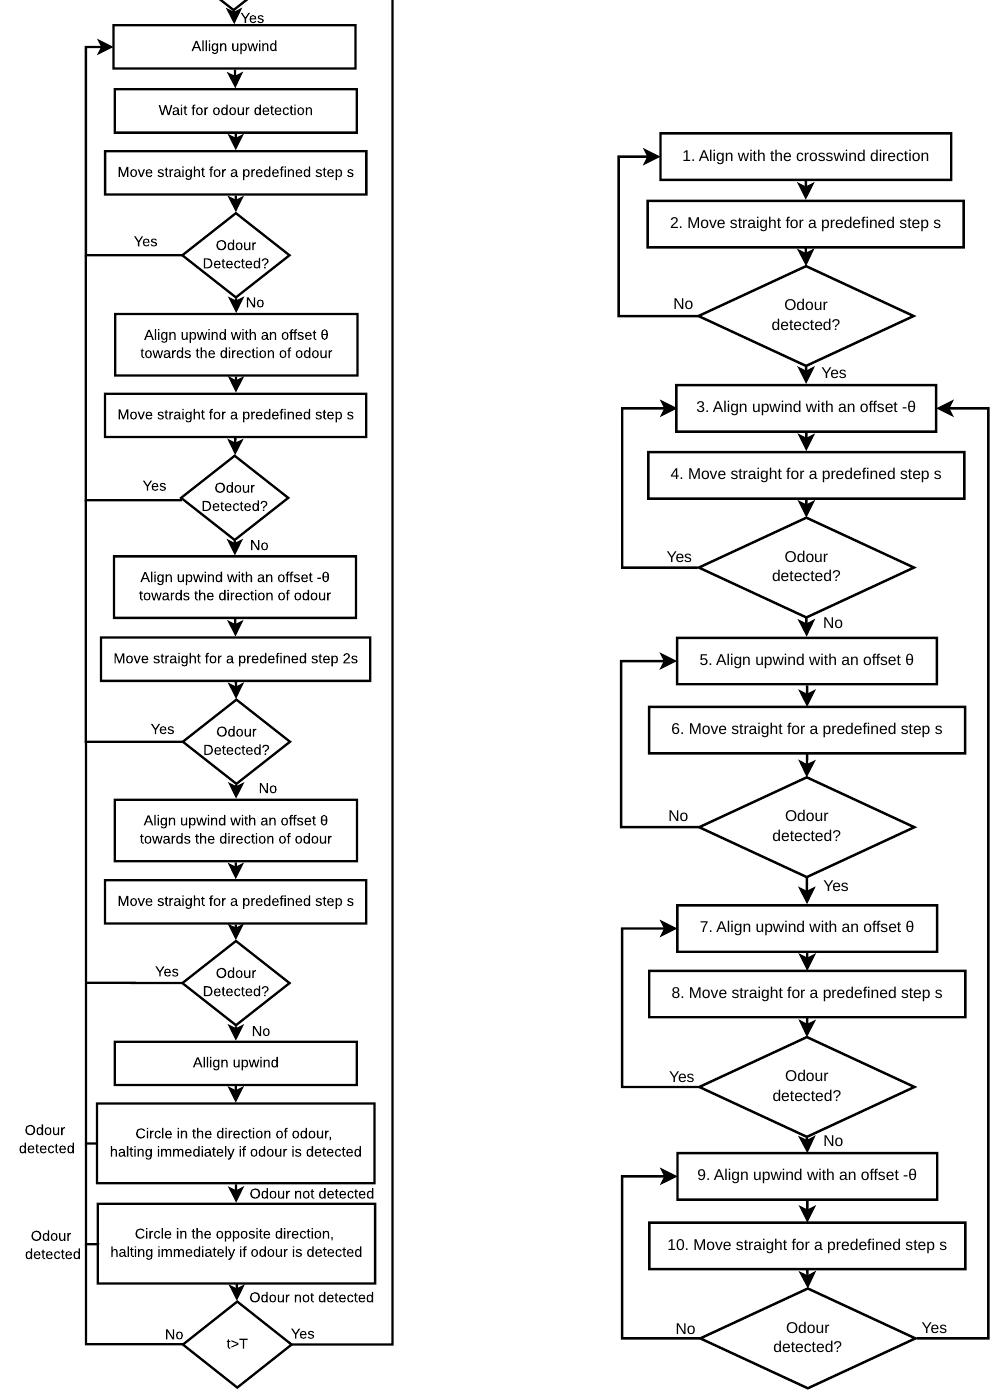
Figure 1. Flow charts of the modified Silkworm Moth ( left ) and Dung Beetle ( right ) algorithms, adapted from [2]. θ and s are user-defined parameters that, respectively, control the amplitude of the rotations and the length of the straight